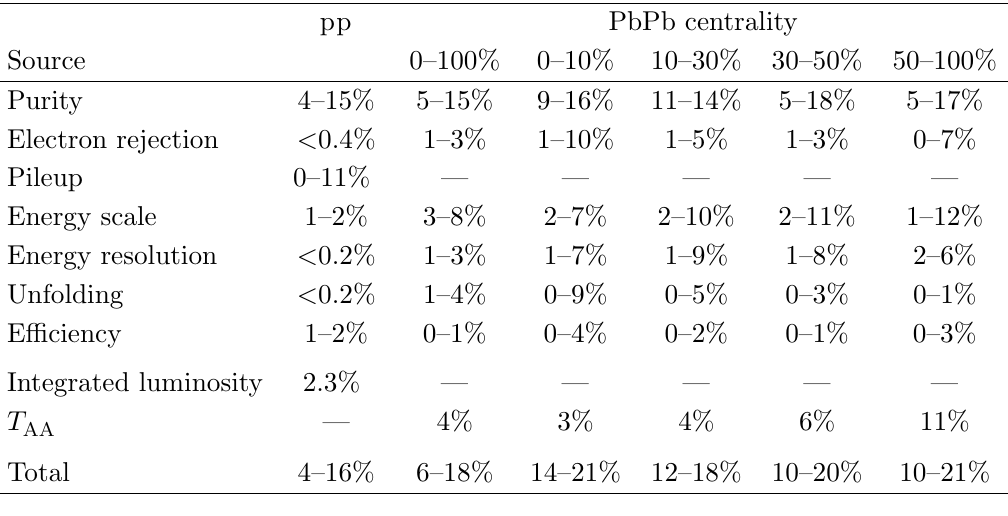
Table 2 . Summary of the contributions from various sources to the estimated systematic uncer- tainties in the cross section of isolated photons in pp and PbPb collisions. When ranges are shown, they indicate the E g -dependent variations of the uncertainties. T